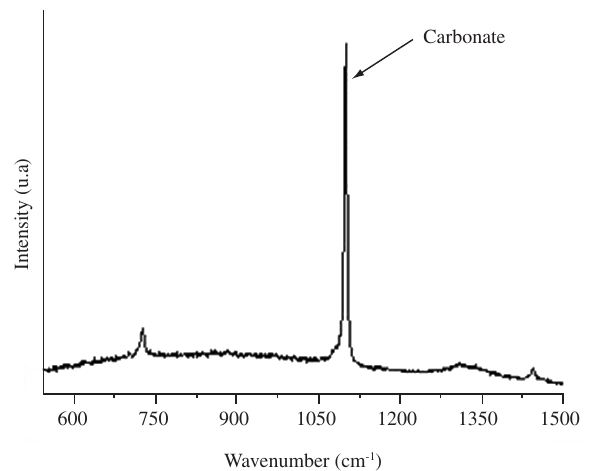
Figure 5. Raman spectrum of ternary sol-gel film heat treated at 400 °C for 15